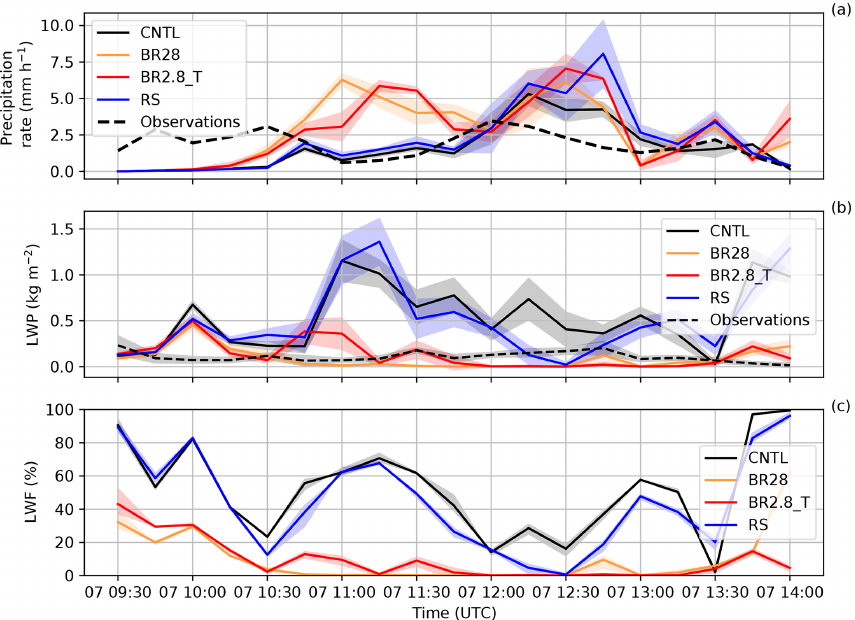
Figure 6. Time series of (a) the precipitation rate from the rain gauge and cloud radar and (b) LWP from the microwave radiometer are compared to all the sensitivity simulations at Davos Wolfgang. We interpolated the precipitation rate, LWP and LWF (liquid water fraction) from the four closest model grid points to Davos Wolfgang. The shaded areas show the model spread for each simulation. Panel (c) shows the LWF (percent) from 09:30 to 14:00UTC on 7 March 2019. The observations, with their 30s frequency, are integrated over 15min intervals. The model precipitation is accumulated over every 15min.